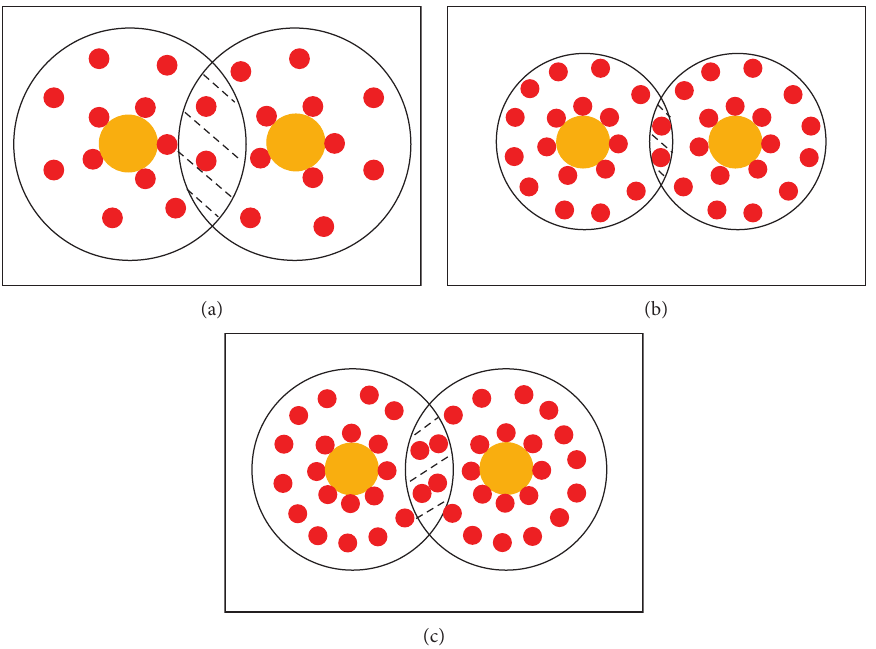
Figure 5: Diagram of variations in double electric layer on particle surfaces at different concentrations of (NH (a) 0.04mol · L − 1 . (b) 0.16mol · L − 1 . (c) 0.28mol · L − 1 . Notes: yellow solid dots are soil particles, red solid dots are cations, and black circles show the double-electrode layer adsorbed onto the particle